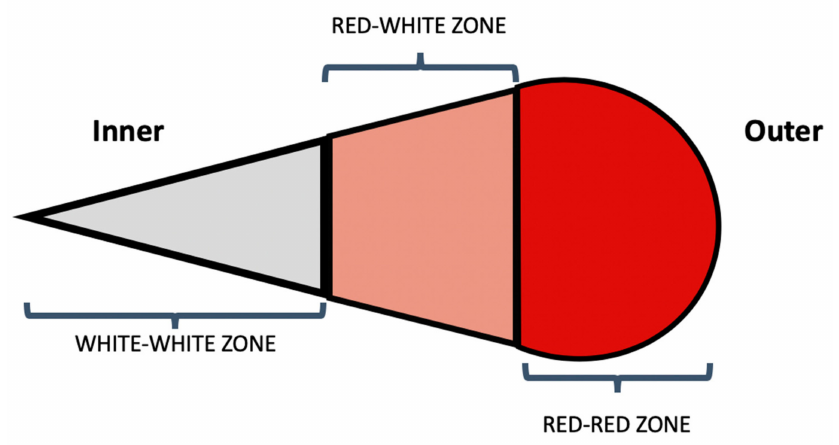
Figure 3. Schematic cross-sectional diagram of the body of the meniscus representing the vascular zones of the